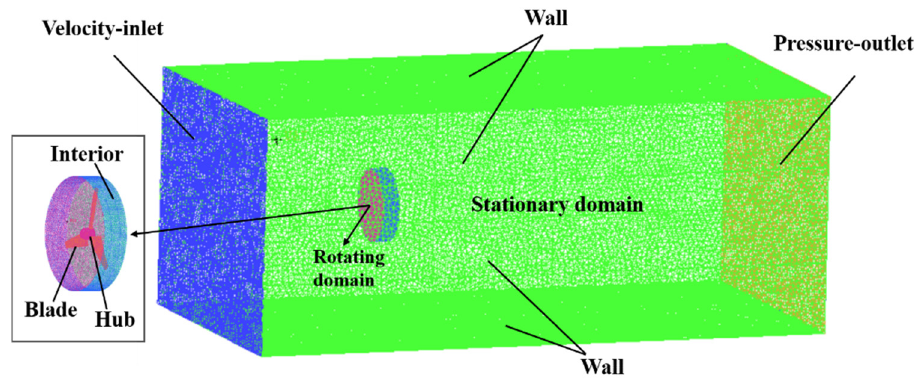
Figure 10. Computational domain and boundary conditions.